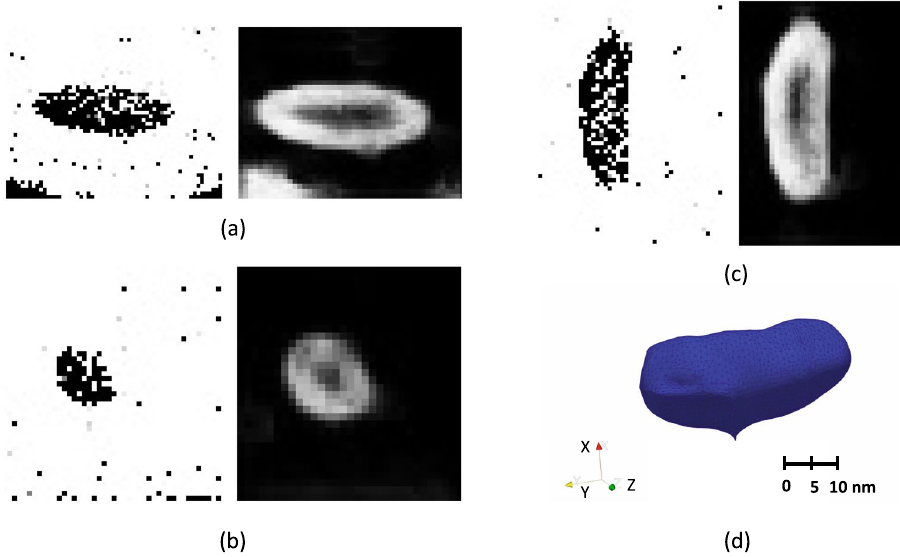
Figure 3. Two- and three-dimensional edge detection map in the experimentally obtained APT data set from an L1 2 -strengthened Al-Si-Sc-Er superalloy. ( a ) Concentration space (left) and edge detection map (right) of a slice along the X-direction, ( b ) Concentration space (left) and edge detection map (right) of a slice along the Y-direction ( c ) Concentration space (left) and edge detection map (right) of a slice along the Z-direction ( d ) the edge surface obtained by merging the edges on slices in the X-, Y-, and